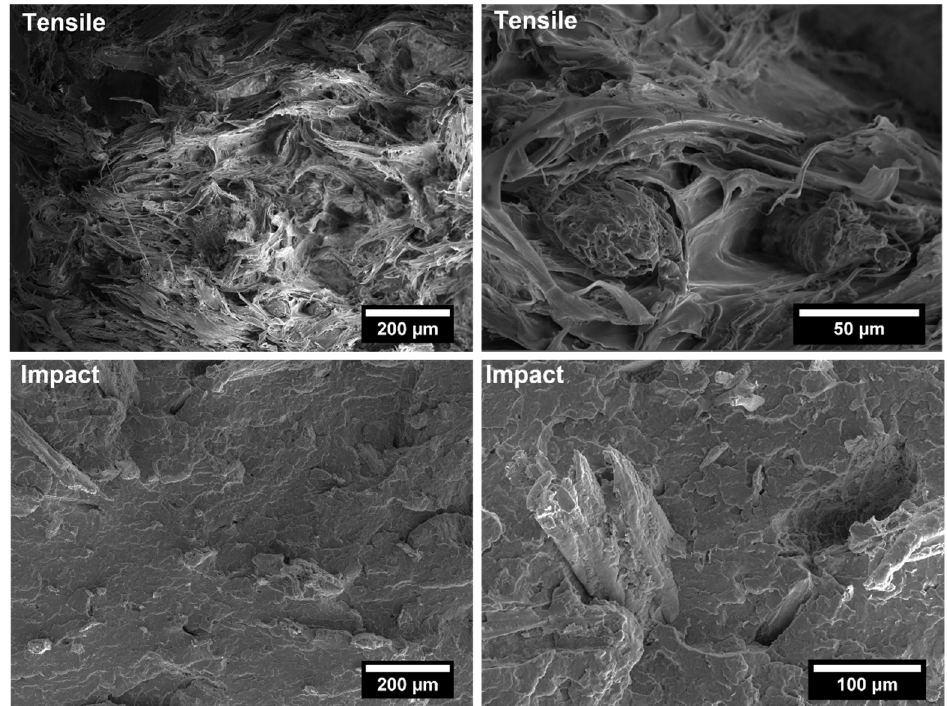
Figure 9. SEM micrographs of PP-based biocomposites with 30 wt.% of holm oak fillers without coupling agent after tensile and Charpy impact tests.